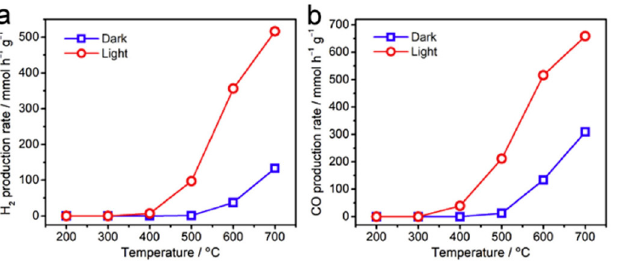
Figure 56. Production rate of ( a ) H 2 and ( b ) CO over MgO/Pt/Zn-CeO 2 under light irradiation and dark conditions. Copyright (2020), reprinted from [46] with permission from Elsevier.